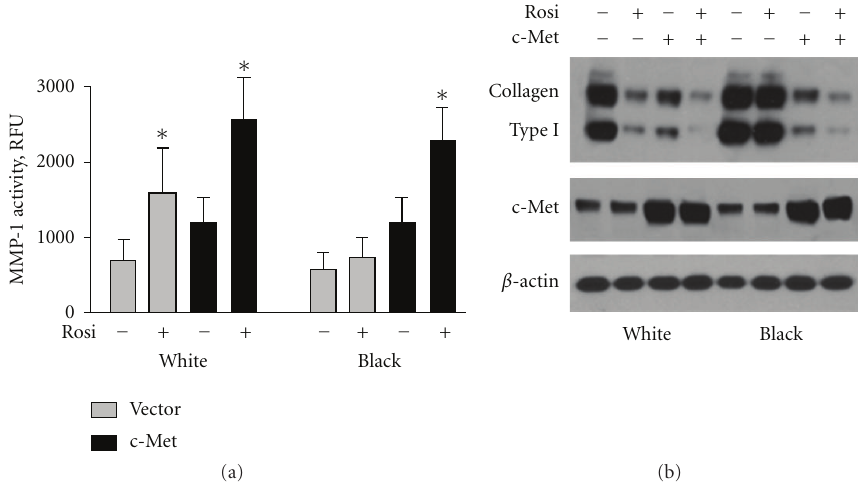
Figure 6: Overexpression of c-Met receptor in lung fibroblasts restores e ff ects of rosiglitazone on MMP-1 (a) and collagen type I (b) in black lung fibroblasts. (a) Each bar represents the mean ± SD of duplicate determinations in four independent experiments. ∗ Statistically significant di ff erences between cells stimulated with rosiglitazone versus nonstimulated cells ( P < 0 . 05). (b) Representative immunoblots from 3 independent experiments performed with 5 white and 5 black cell lines are presented. Anti- β -actin antibody was used as the sample loading